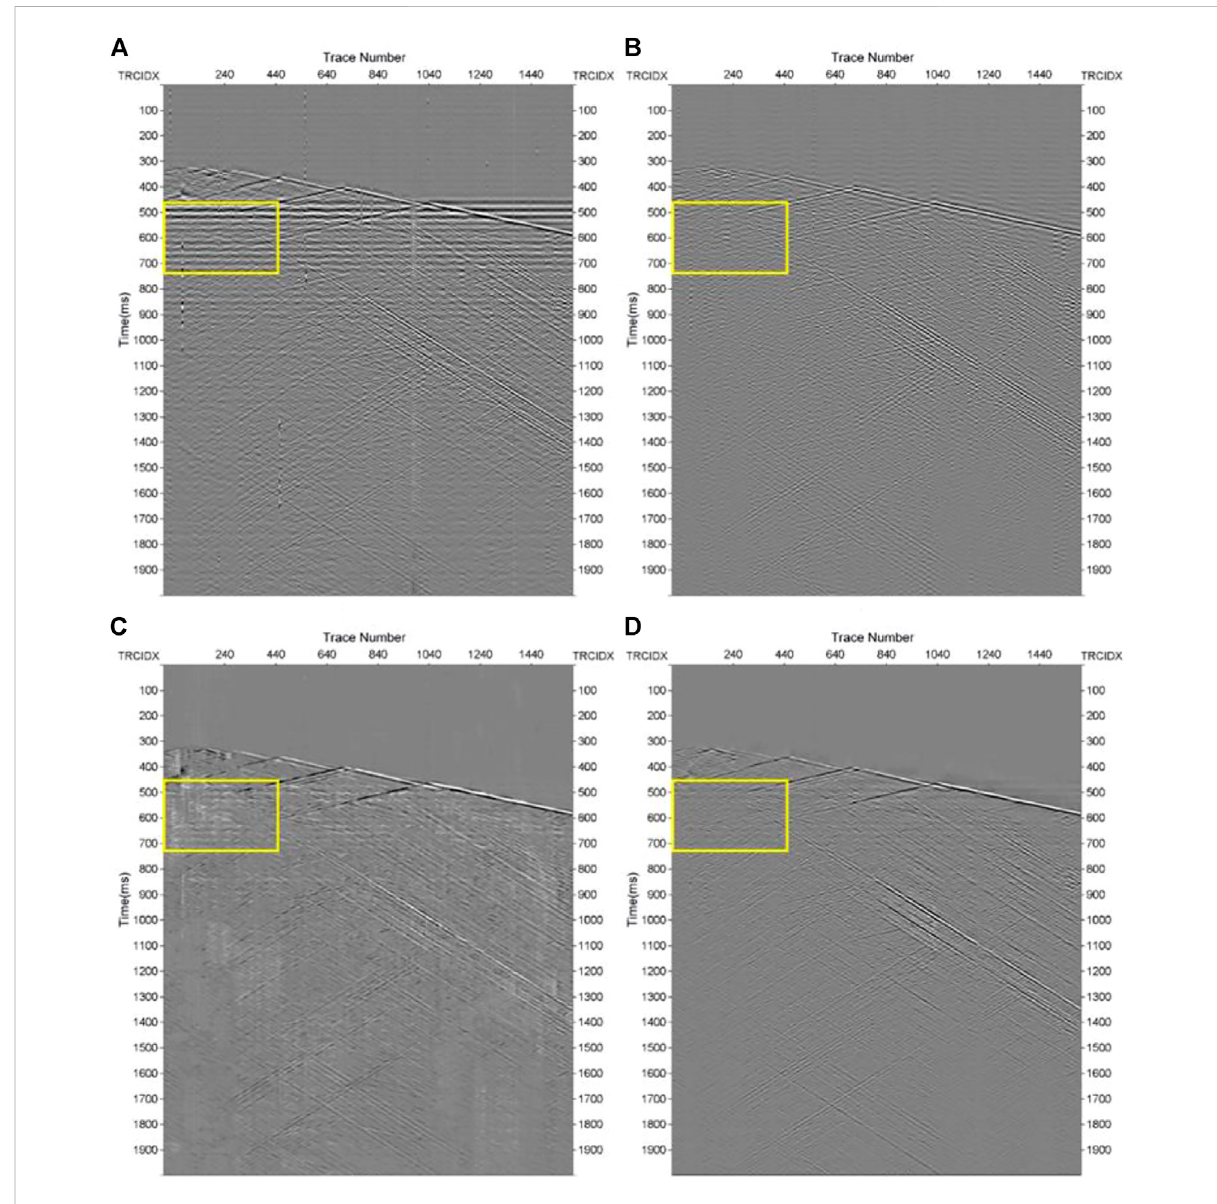
FIGURE 12 Field data: Denoising results. (A) Denoised result from VMD, (B) denoised result from band-pass fi ltering, (C) denoised result from DnCNNs, (D) denoised result from ADNet.